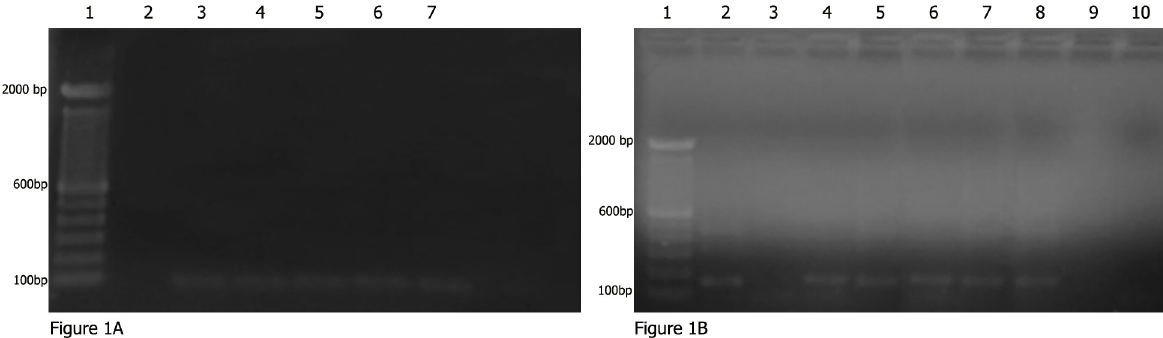
Fig 1. PCR amplification products in agarose gel electrophoresis (A) Detection of human β -globin DNA in all 5 patients (3 to 7) by the control PCR. (1) Molecular marker DNA ladder, 100 bp (Invitrogen), (2) negative control (Blank), and (3–7) DNA of the patient’s CSF. (B) Detection of Sporothrix by nested PCR obtained for the DNA of the patient’s CSF. (1) Molecular marker DNA ladder, 100 bp (Invitrogen), (2) positive control (DNA of Sporothrix spp.), (3) negative control (Blank), (4–8) DNA of the patients CSF, (9) negative control (DNA Cryptococcus neoformans ), and (10) negative control (Blank). CSF, cerebrospinal fluid.